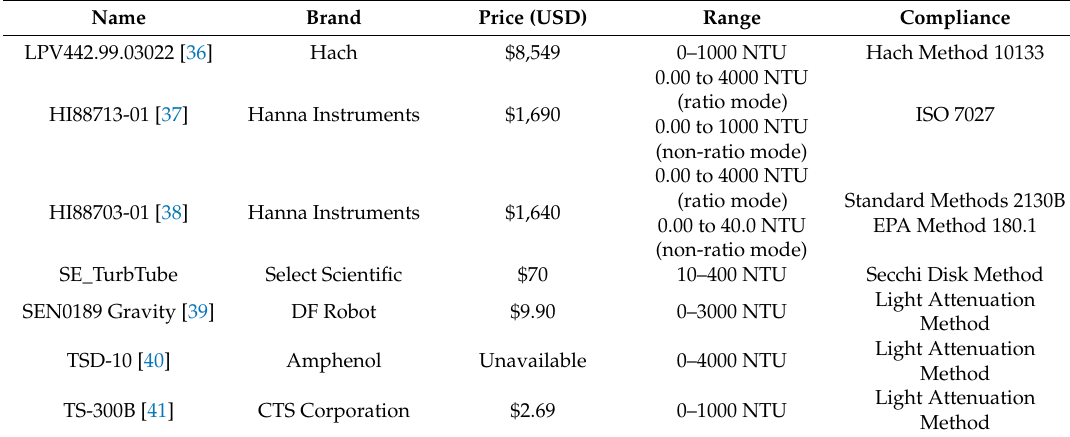
Table 3. A cost comparison of turbidity measurement devices.